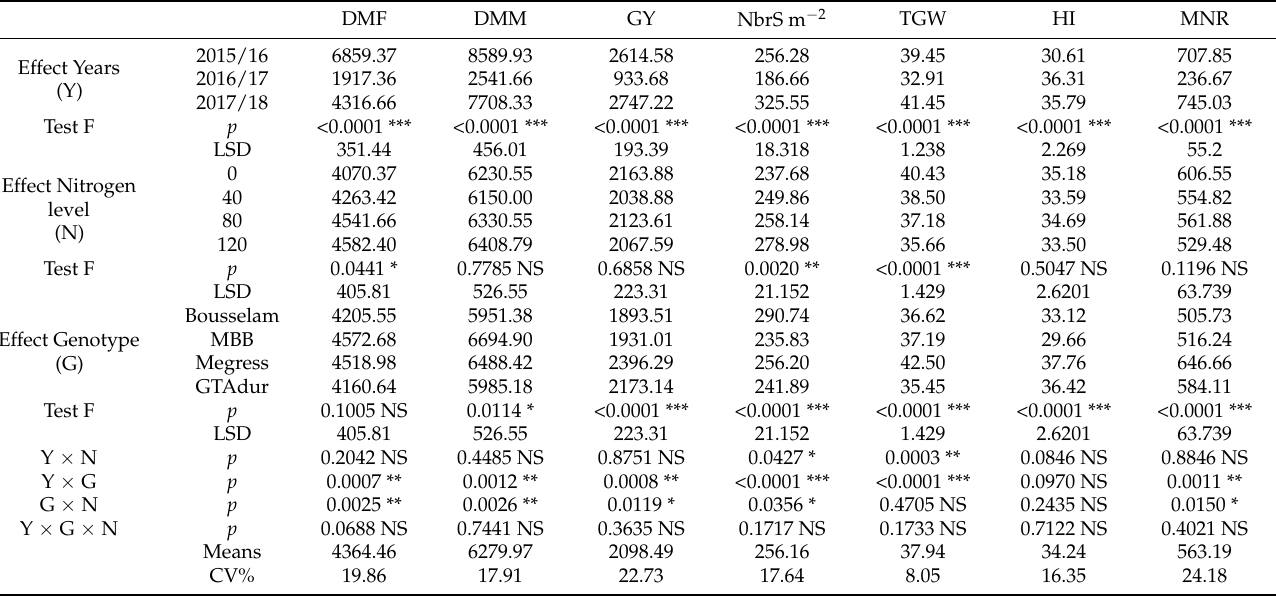
Table 4. Means and ANOVA results of dry matter accumulated at flowering and maturity and grain yield and its